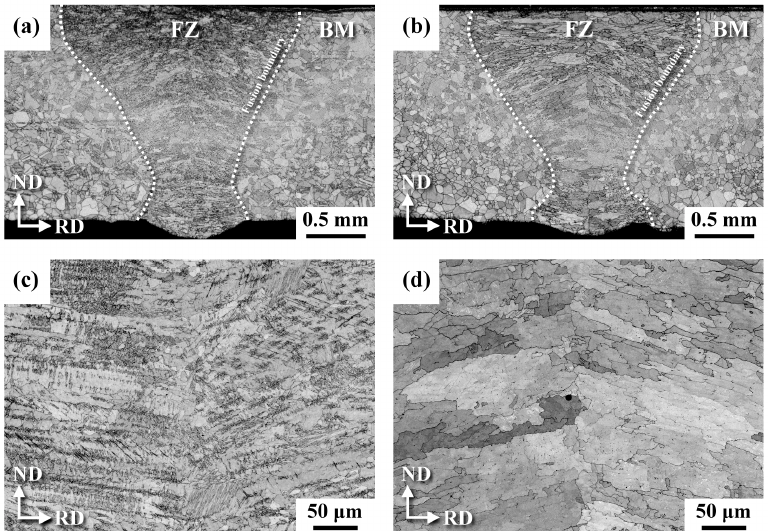
Figure 2. Macro-views of the ( a ) 304 and ( b ) 316 laser welds; FZ microstructures of the ( c ) 304 and ( d ) 316 welds in a cross-sectional view.